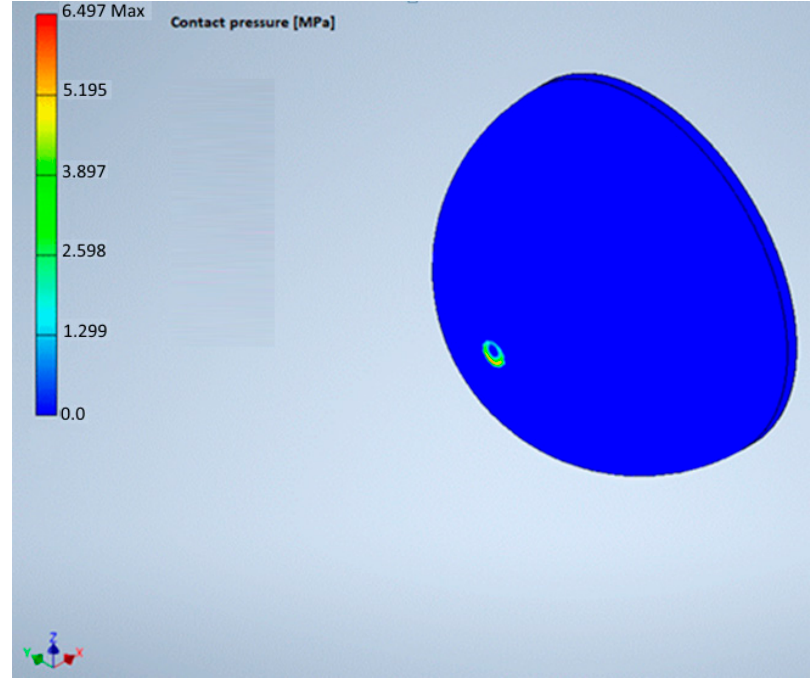
Figure 20. The contact pressure between the tilt arm and the tested material sample. The resulting displacement u X is listed in Table 2. It is clear that the Poisson ratio had a much smaller effect then the Young modulus of the bearing material on the displacement u X . Table 2. Values of Young modulus E , the Poisson ratio ν , and displacement 𝑢 (cid:3025) obtained from sim- ulations for various values of the loading force F .